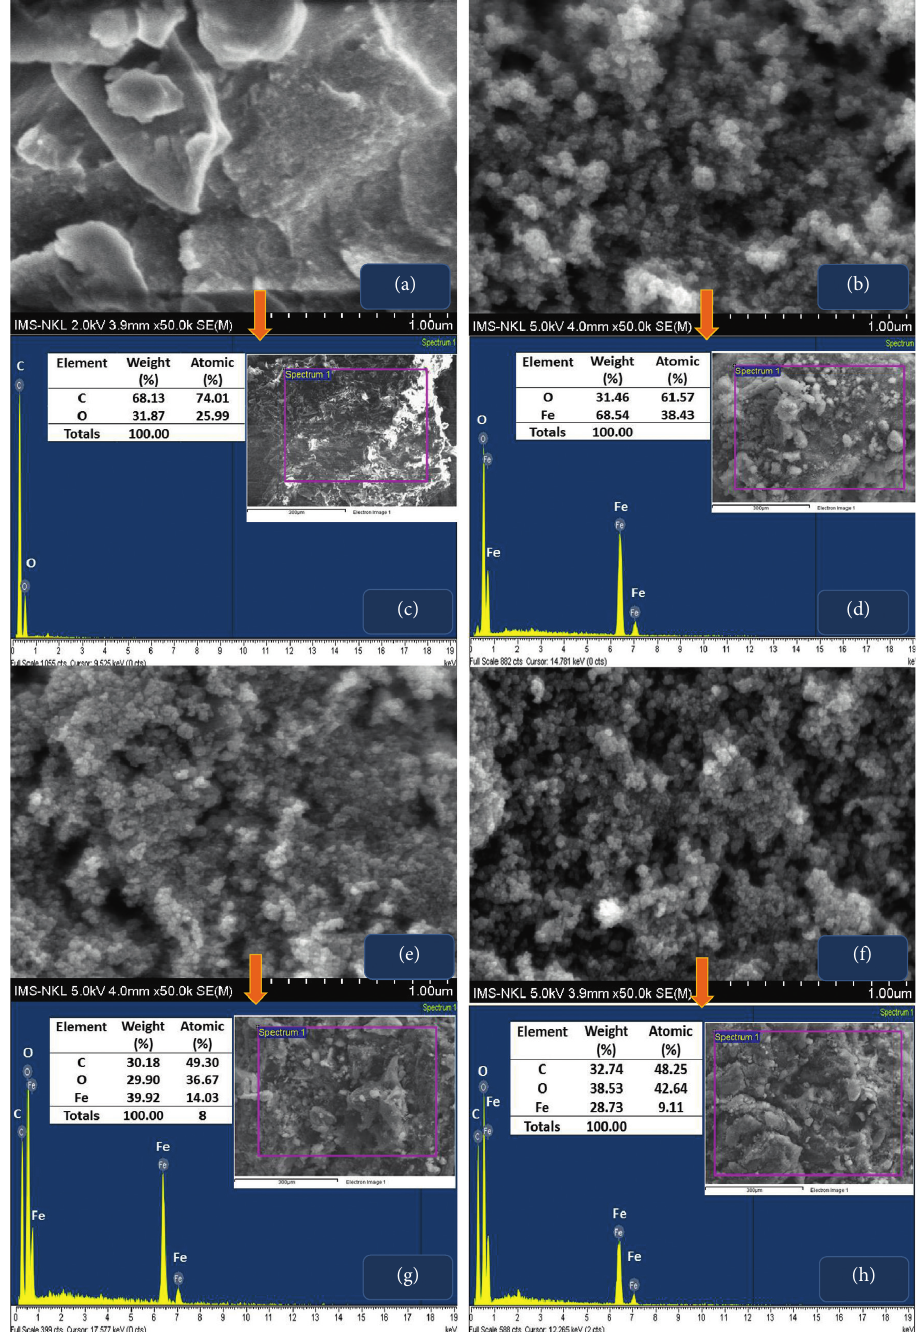
Figure 3: SEM and EDX spectra of PPB (a, c), Fe 3 O 4 nanoparticles (b, d), FO5-PPB before adsorption (e, g), and after adsorption (f,